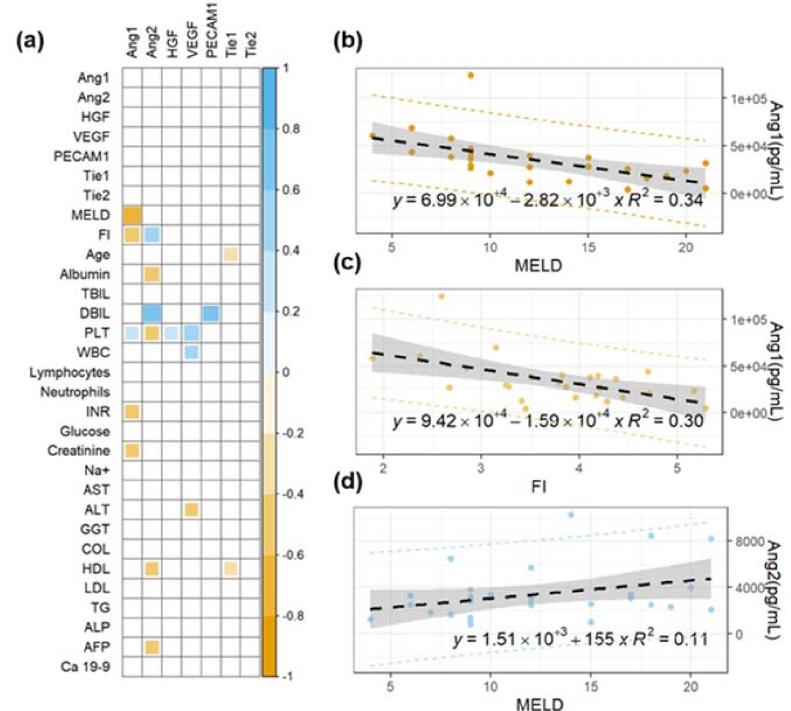
Figure 1. ( a ) Correlation matrix of Spearman’s coefficients, ρ , between the investigated angiogenesis markers and a panel of selected plasma biochemical parameters and clinical scores for cirrhosis staging (MELD and FI). A double color scale is used to assess the direction of the correlations, with negative values displayed in orange and positive ones in light blue. The strength of the significant correlation is directly proportional to the pixel size and the pixel intensity. Non-significant correlations are indicated as empty white pixels. Linear regression analysis of selected angiogenesis markers (angiopoietin-1 and angiopoitin-2) as a function of widely used clinical scores for cirrhosis staging ( b – d